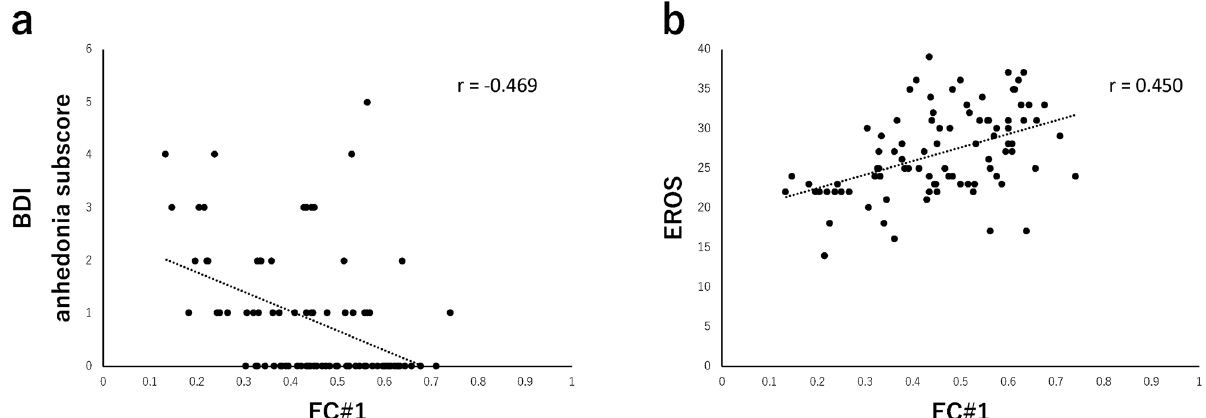
Figure 2. A scatter plot of correlations between the identified functional connections (FCs) and clinical scores. ( a ) FC#1 shows a negative correlation with the BDI anhedonic subscore (r = − 0.469, p < 0.006*). ( b ) FC#1 shows a positive correlation with EROS score (r = 0.450, p < 0.006*). *Bonferroni-adjusted significance level of p < 0.05/8 (= 0.006). BDI Beck’s Depression Inventory, EROS Environmental Reward Observation